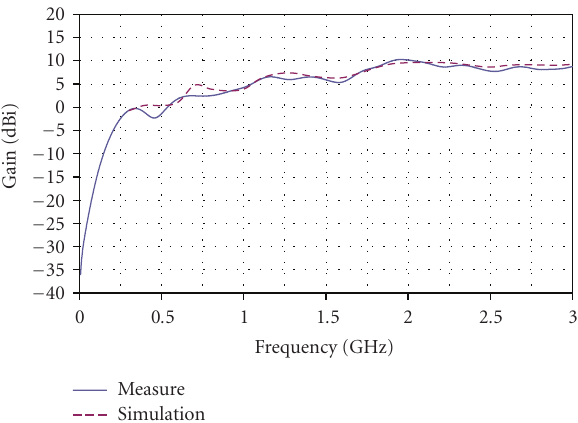
Figure 3: Gain of the elementary